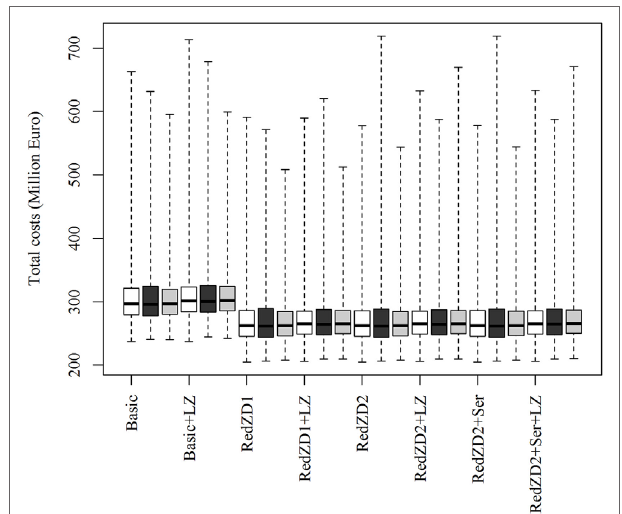
FigUre 2 | Box plots of the predicted total costs of African swine fever-epidemics using different control scenarios with changed values of the proportion of sick and dead animals (SIED) needed for detection of infected herds to occur. The empty, black and gray boxes represent the control scenario with the default, reduced and increased SIED value, respectively. Basic: (1) culling, cleaning, and disinfection of affected herds; (2) 3-day national standstill on animal movements; (3) 3-km protection zone—duration 50 days + 10-km surveillance zone duration 45 days (movements and contact restrictions in zones); and (4) tracing of movements and contacts. Basic + LZ: basic control + surveillance zone 15 km (default: 10 km). Red. ZD1: Basic + duration of protection and surveillance zones 35 days (default: 50 and 45 days). Red.ZD1 + LZ: Red.ZD1 + surveillance zone 15 km (default: 10 km). Red.ZD2: Basic + duration of protection and surveillance zones 35 and 25 days, respectively (default: 50 and 45 days). Red.ZD2 + LZ: Red.ZD2 + surveillance zone 15 km (default 10 km). Red.ZD2 + Ser: Red. ZD2 + serological testing in surveillance zone before lifting the zone (default: clinical surveillance). Red.ZD2 + Ser + LZ: Red.ZD2 + Ser + surveillance zone 15 km (default:10 km).